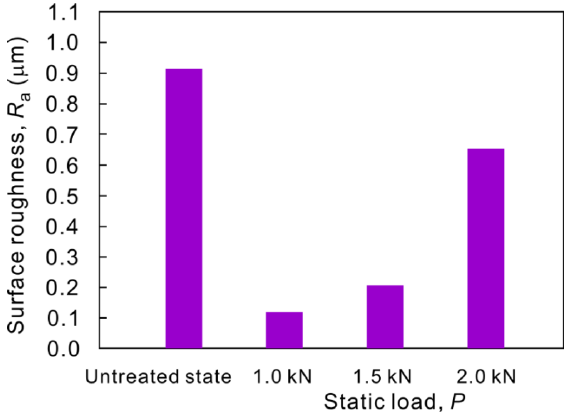
Figure 3. Surface roughnesses R a of untreated and USRP-treated specimens with different static loads P . The R a is the average value of several measurements.